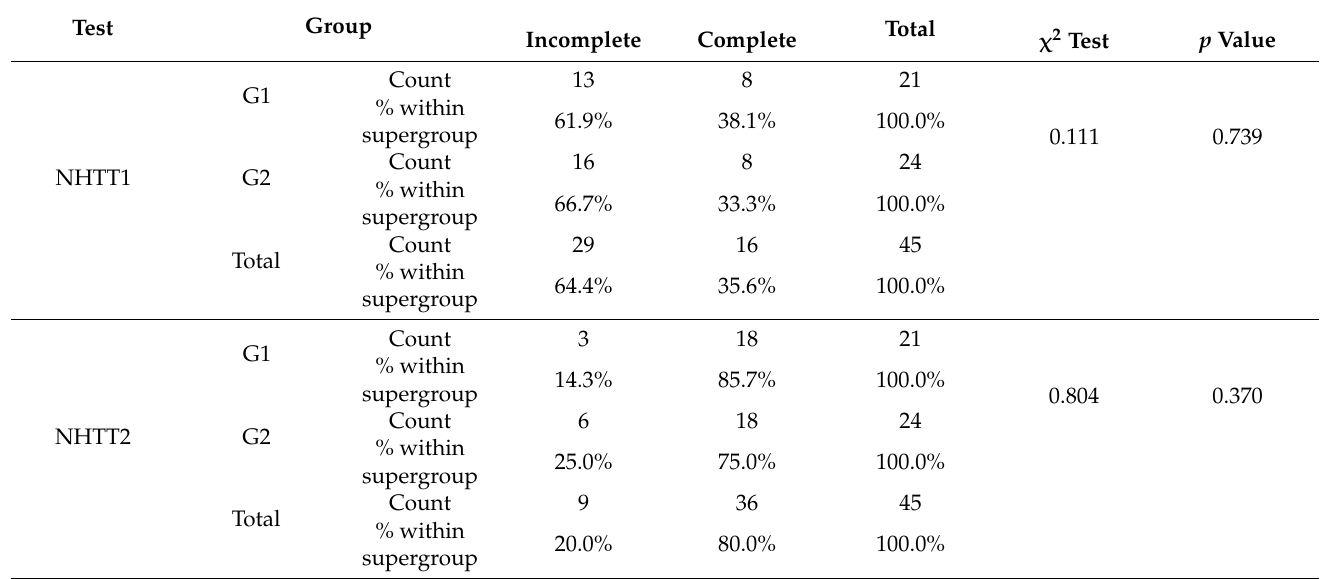
Table 3. Distribution of the population into subgroups according to completion of the test.